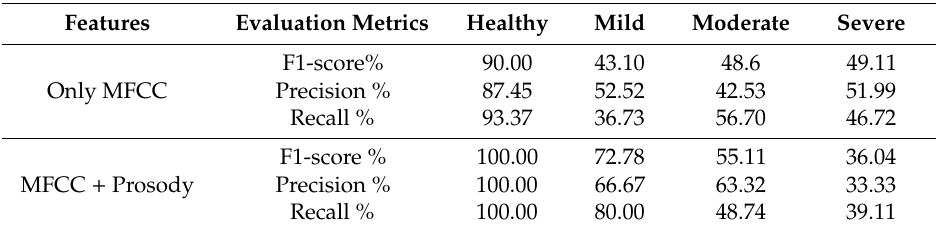
Table 12. Evaluation metrics for all severity groups when using an RF